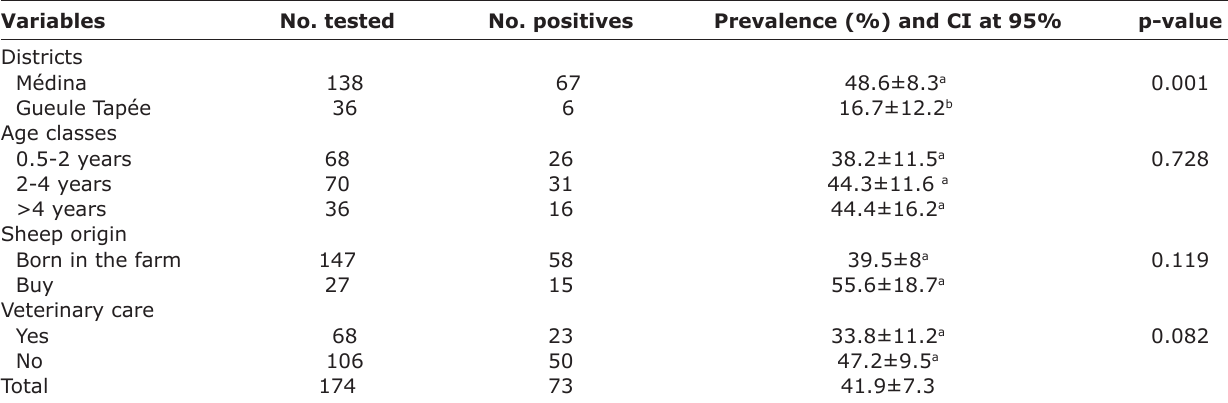
Table-2: Factors associated with the infection to Neospora caninum in sheep, Dakar, Senegal, 2014. Variables No. tested No. positives Prevalence (%) and CI at 95%